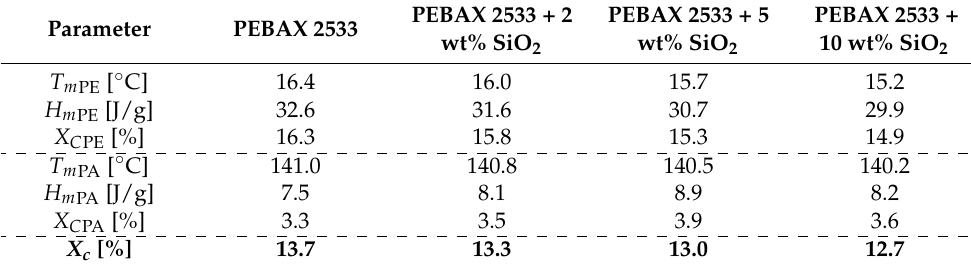
Table 2. DSC analysis results for membranes containing SiO 2 .